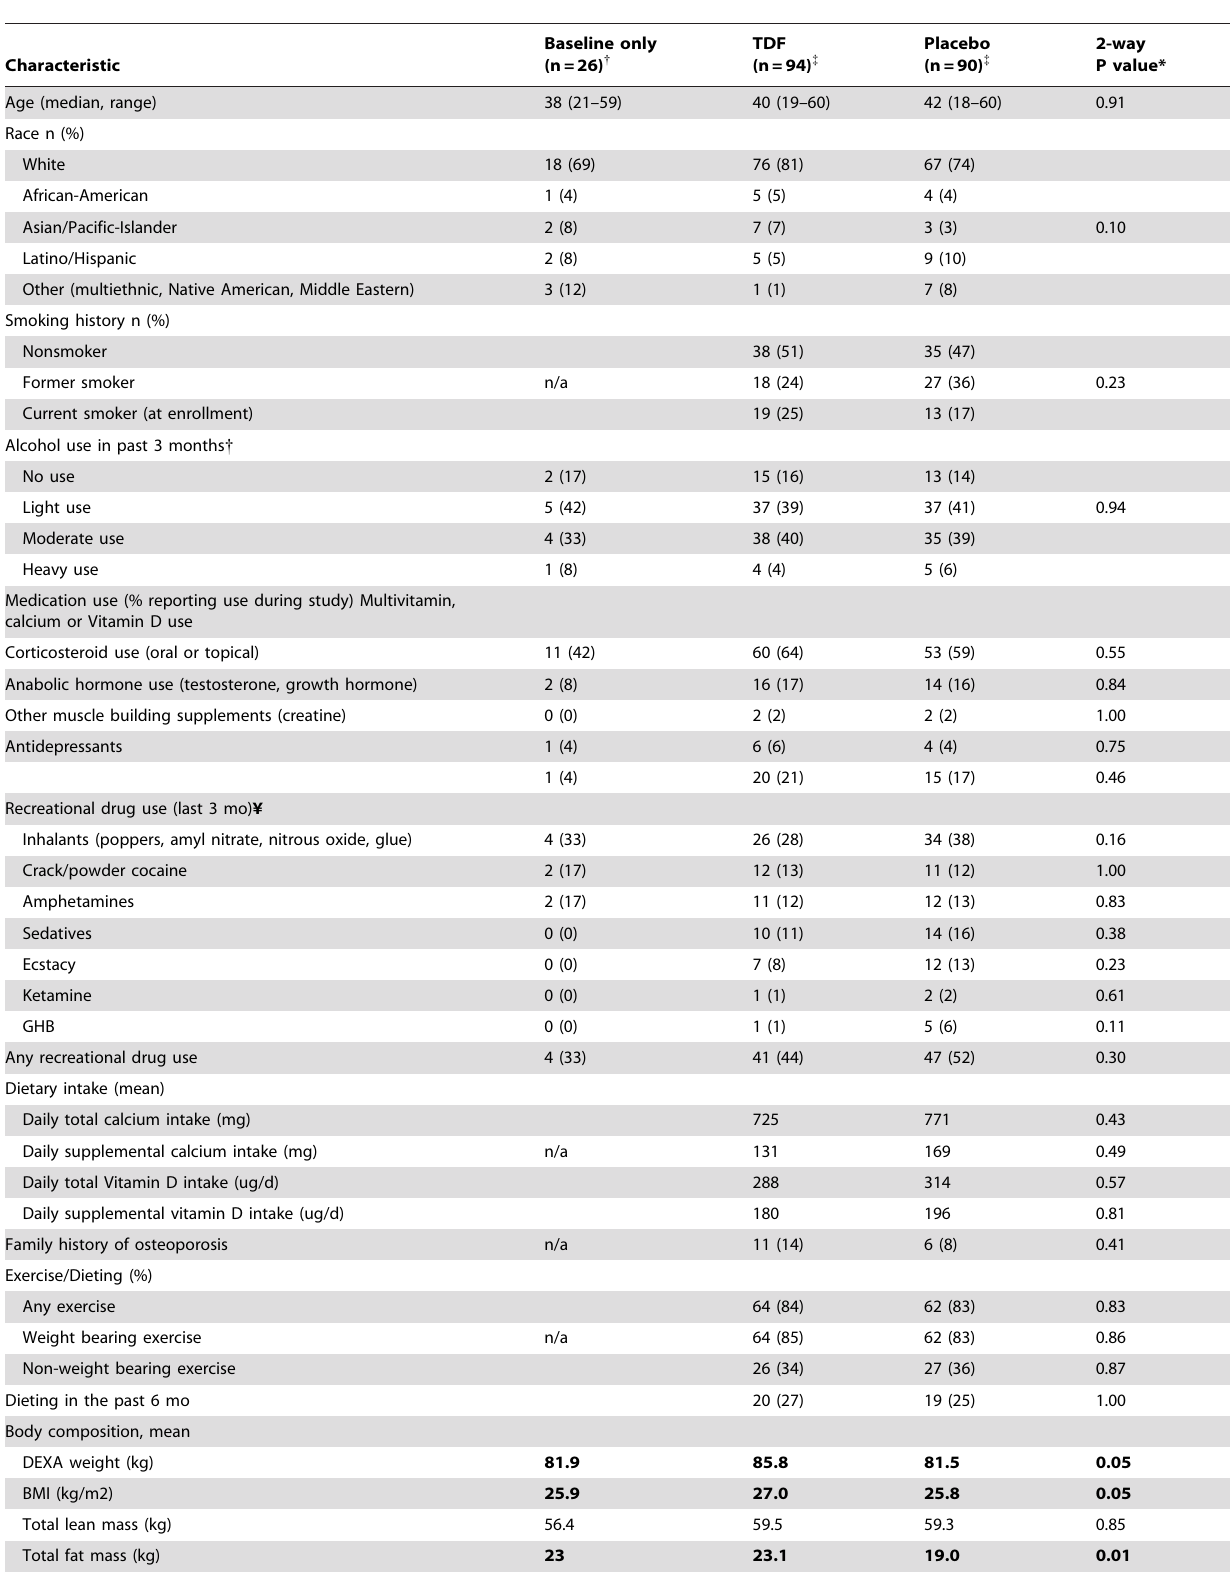
Table 1. Baseline characteristics of participants in the baseline only and longitudinal analysis